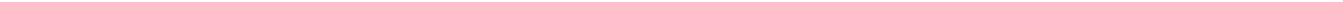
Fig. 1 Mouse Ccdc88b expression in colon during DSS-induced colitis. Wild type (WT) mice were either not treated (NT) or given 3% DSS for 5 days followed by 3 days of water. a Ccdc88b mRNA expression in distal colons of NT ( n = 3) or DSS-treated WT mice ( n = 3 for each time point) at the indicated days. Data represent expression relative to hprt ± SEM ( n = 3). * P < 0.05, ** P < 0.01 (two-tailed Student ’ s t -test) and are representative of one experiment. b Representative immunoblots for Ccdc88b protein detected in extracts from distal colons from NT or DSS-treated WT and Ccdc88B mut mutant mice at indicated time points, and densitometric quanti fi cation of Ccdc88b immunoblot normalized to β -actin ± SEM ( n = 3) (representative of one of two independent experiments); ** P < 0.01 (two-tailed Student ’ s t -test). c Representative confocal microscopy images of tissue sections from colon of NT or DSS-treated mice at indicated times, and stained with antibodies against Ccdc88b (red), CD45 (green), and E-Cadherin (purple) and nuclei staining DAPI (blue). Scale bars, 100 μ m. d Representative FACS plots and quanti fi cation of lamina propria cells stained for CD45 and for Ccdc88b antibodies for NT ( n = 3) and DSS-treated WT mice ( n = 4 for each time point) at indicated time points, data are representative of one experiment. e Representative confocal microscopy images of tissue sections from colon of NT or DSS-treated mice at day 8, and stained for Ccdc88b (red), CD3 (green) and CD11b (green); nuclei are stained with DAPI (blue). Scale bars, 100 μ m. f same as in e for Ccdc88b (red), CD4 (green) and CD8 (green). Scale bars, 100 μ